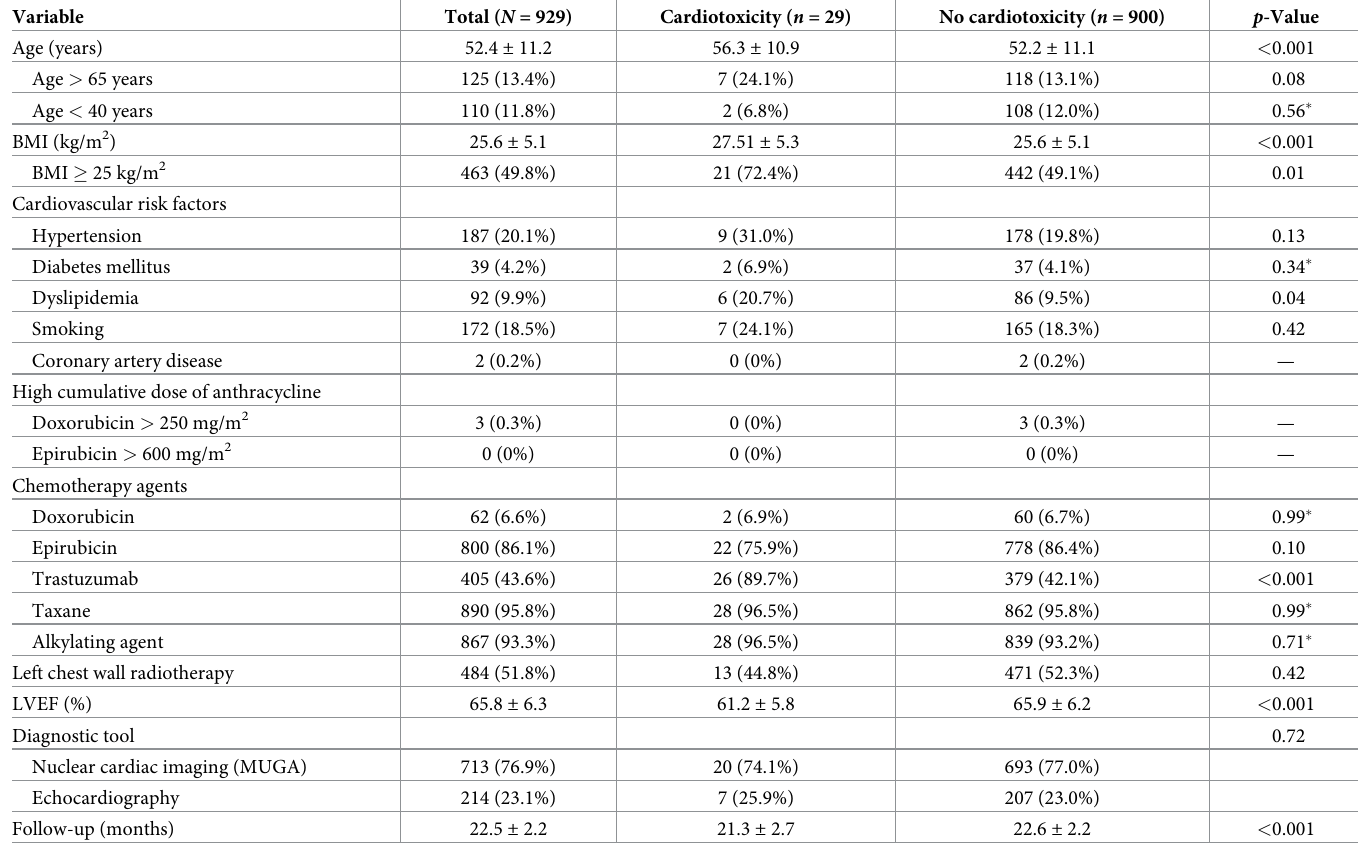
Table 1. Baseline